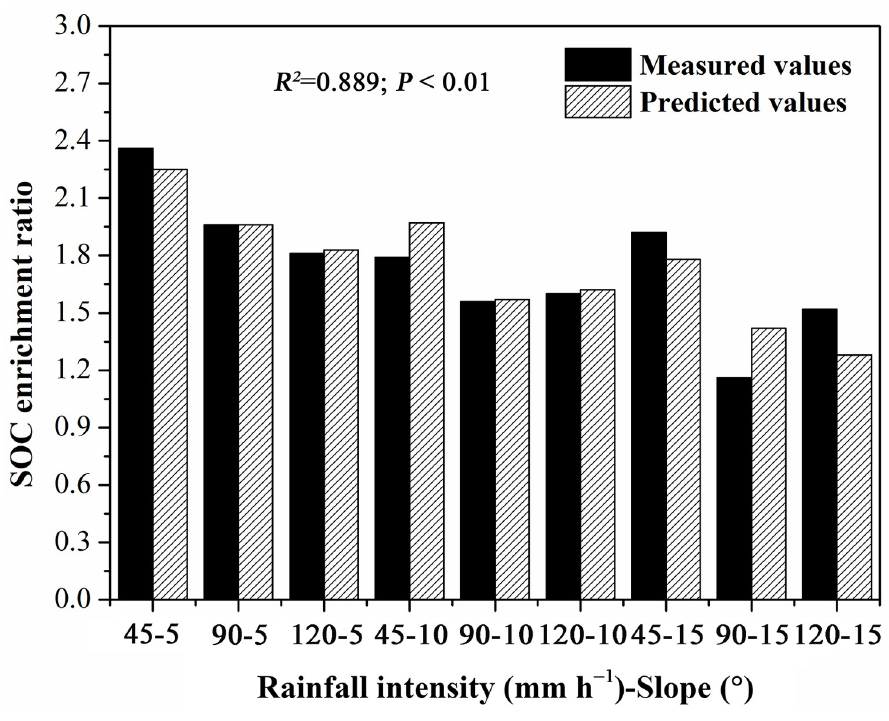
Fig 9. Calculated results of ERocs regressed